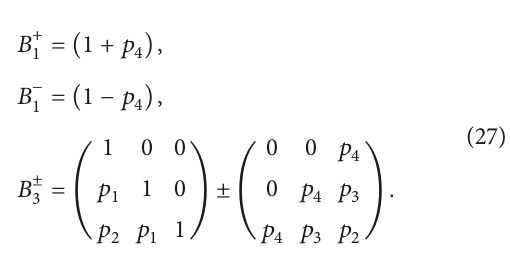
(iii) The determinants of the 1×1 matrices 𝐵 ± 1 and the